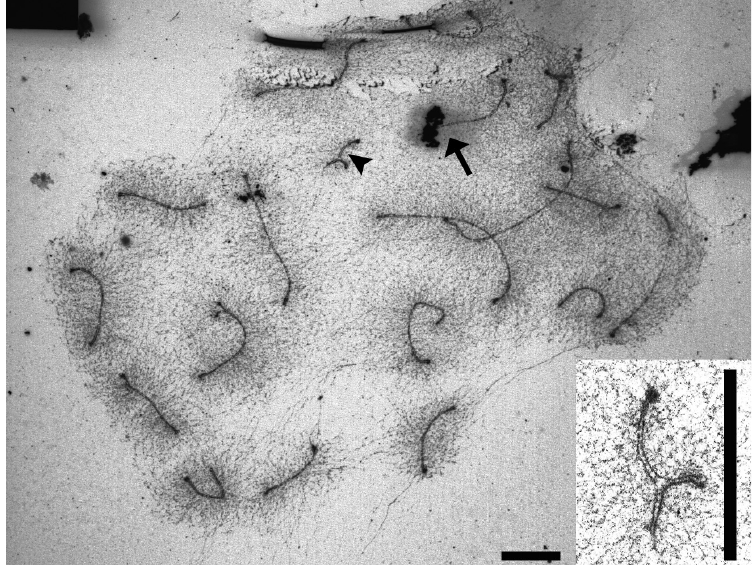
Figure 7. Ag-NOR stained SC spread of the sand lizard heterozygous for the long variant of chromo- some 19. The arrowhead and insert show heteromorphic SC 19. The arrow shows NOR at a macrochro- mosome. Scales bars: 5